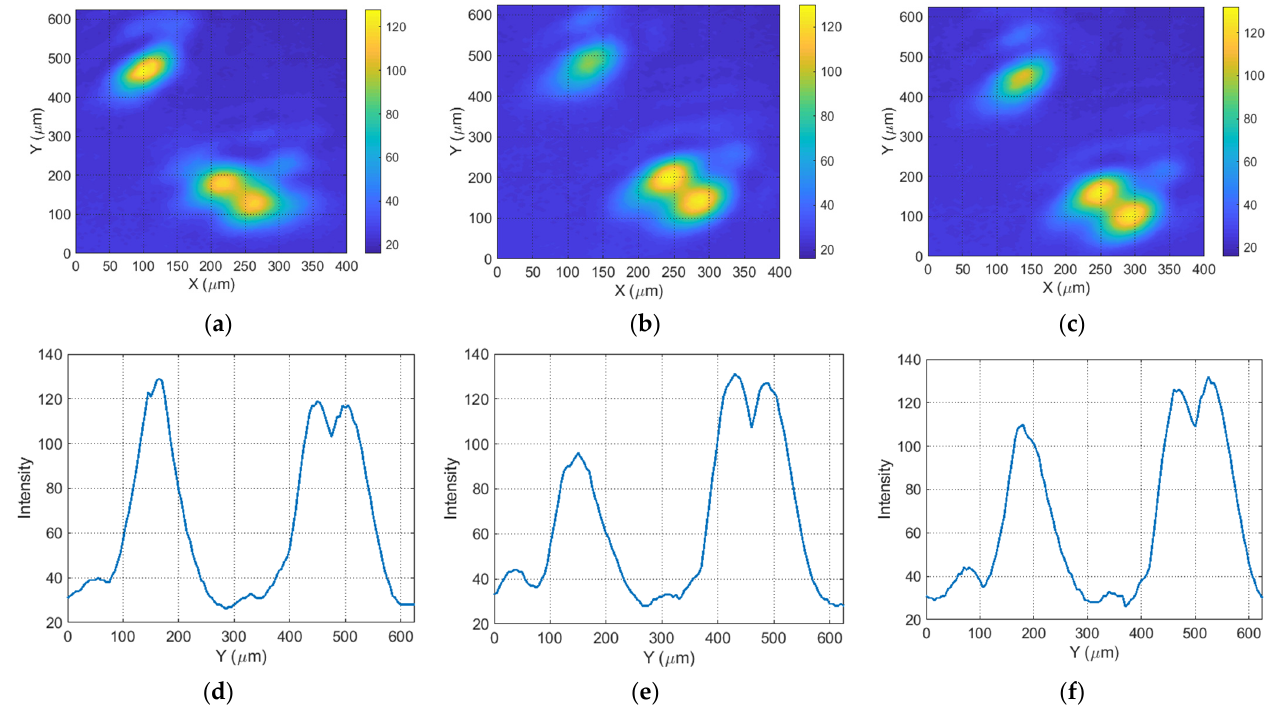
Figure 5. Two-dimensional distribution of the intensity: ( a ) for value offset 0.23 λ and for wavelength λ 1 = 473 nm; ( b ) for value offset 0.43 λ and for wavelength λ 2 = 532 nm; ( c ) for value offset 0.5 λ and for wavelength λ 3 = 561 nm. Maximum values of the intensity distribution along the 0 y axis: ( d ) for case ( a ); ( e ) for case ( b ); ( f ) for case ( c ).